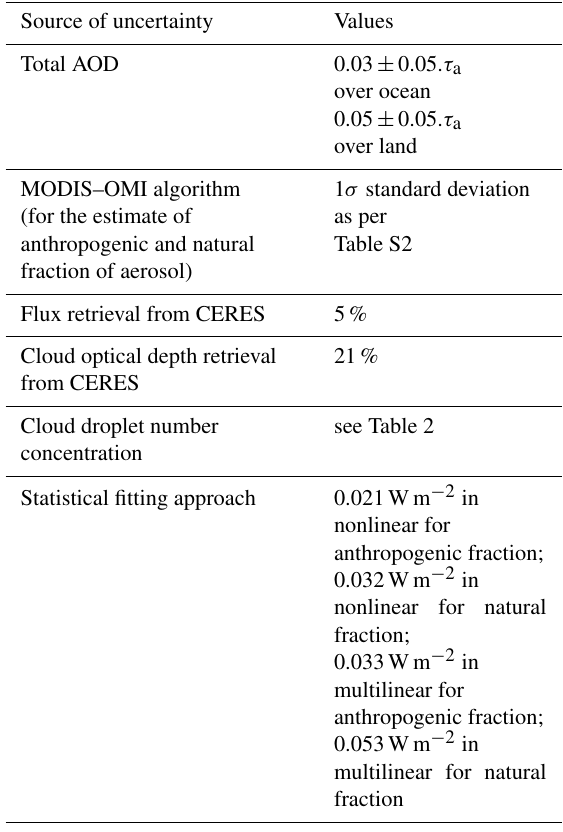
Table 3. Lists the sources of uncertainties and their values involved in the satellite-based estimate of RF aci in the present